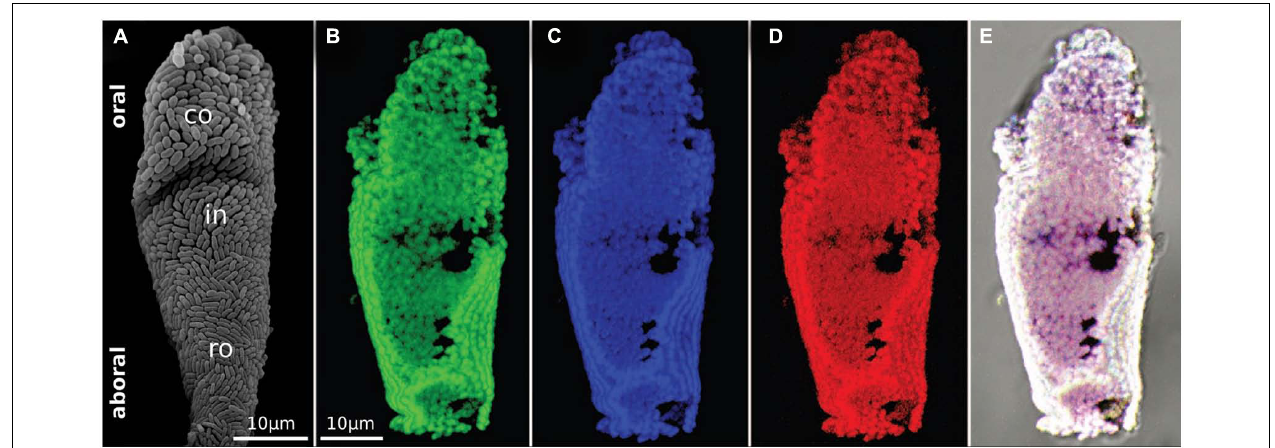
FIGURE 5 |The monospecific ectosymbiont monolayer. (A) SEM observation of a microzooid showing the monolayer of bacteria covering the host cell.The two morphotypes are visible, rod-shaped symbionts at the aboral part and coccioid symbionts at the oral part. (B–D) FISH micrographs of